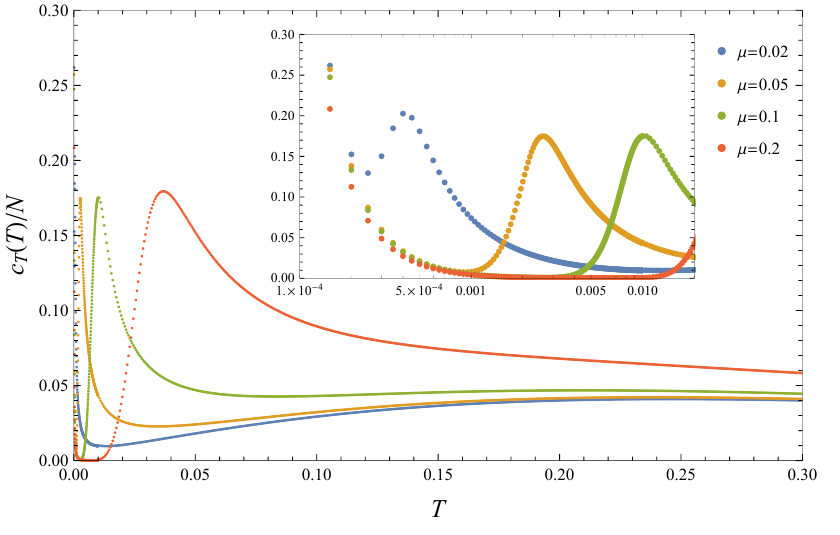
Figure 10 . The large N speci(cid:12)c heat c T horizontal axis is the temperature T . Note that the universal increasing behavior at T numerical artifact due to the fact that the numerical UV cuto(cid:11)